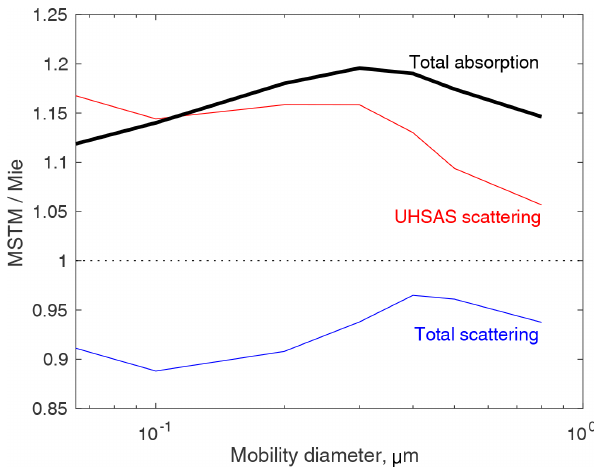
Figure B1. Comparison of scattering and absorption calculated from Mie theory with that from MSTM v3.0. Mie calculations as- sumed spheres with diameter equal to mobility diameter and refrac- tive indices were volume-weighted averages of soot and air (Liu and Daum, 2008). Soot volume was determined from Gysel et al. (2011). MSTM calculations assumed particles were assemblies of 20nm spheres equaling the masses derived from Gysel et al. (2011) all packed into a spherical volume with diameter equal to mobility diameter plus 20nm.